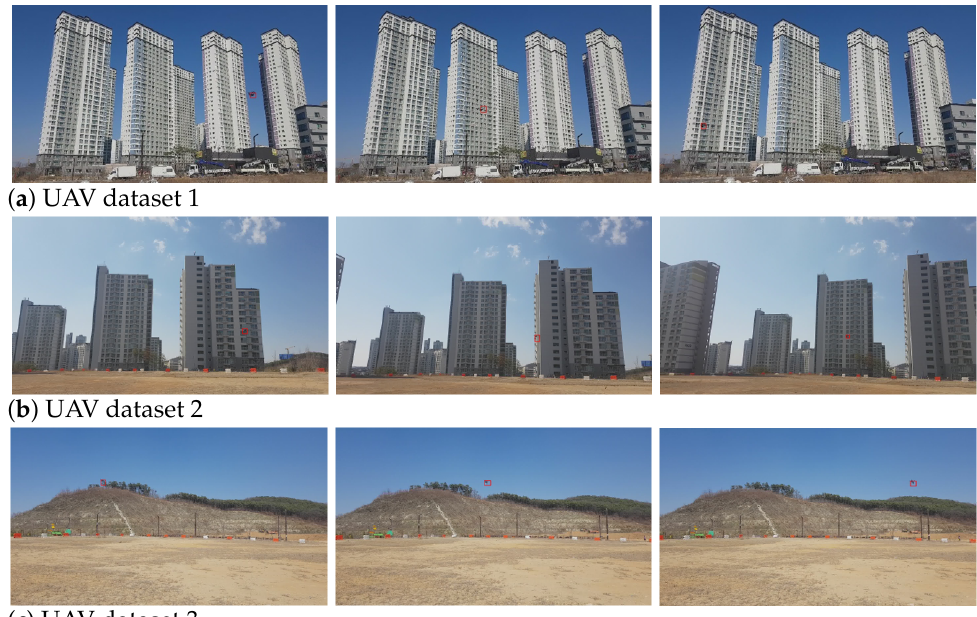
Figure 5. Qualitative results 2 using our UAV datasets. Red boxes denote visual tracking results of the proposed